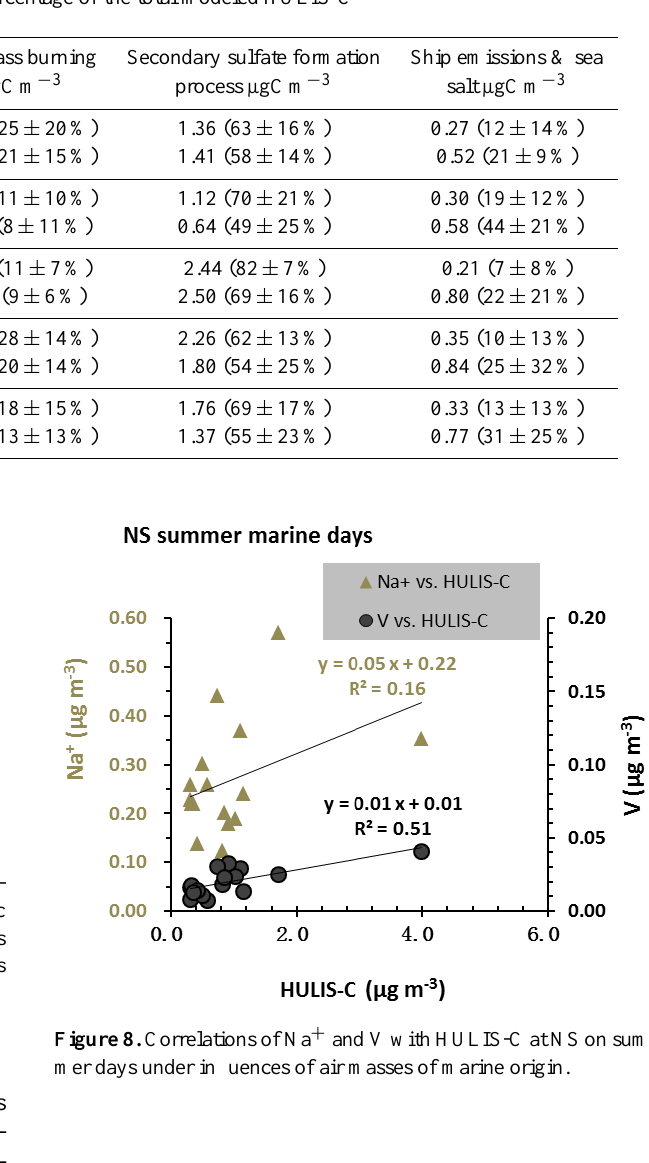
Table 2. Contribution to HULIS-C from individual sources and percentage of the total modeled HULIS-C